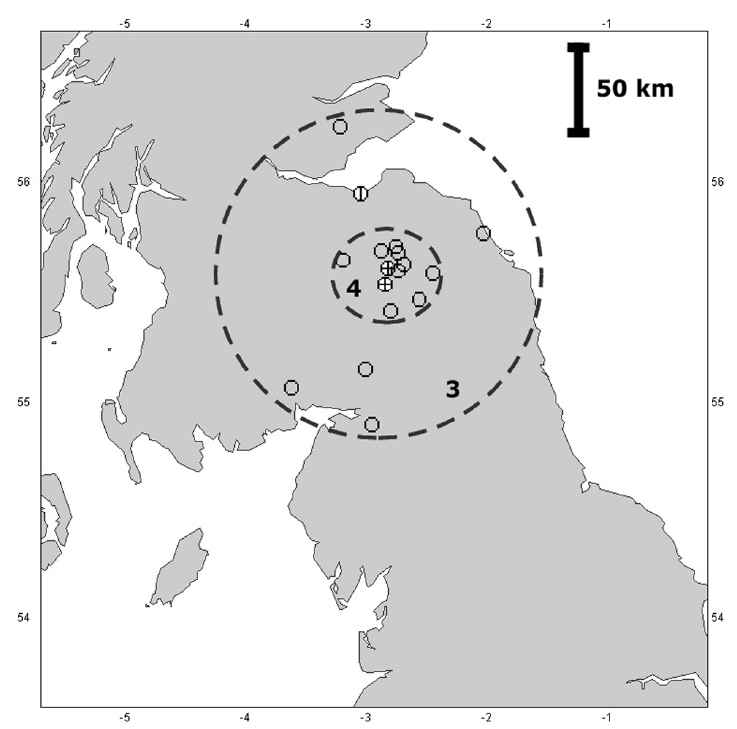
Fig. 7. Intensity and isoseismal map for the 1728 Galashiels earthquake, using standard intensity symbols. Un- filled circles indicate places where the earthquake was felt, but few or no details are